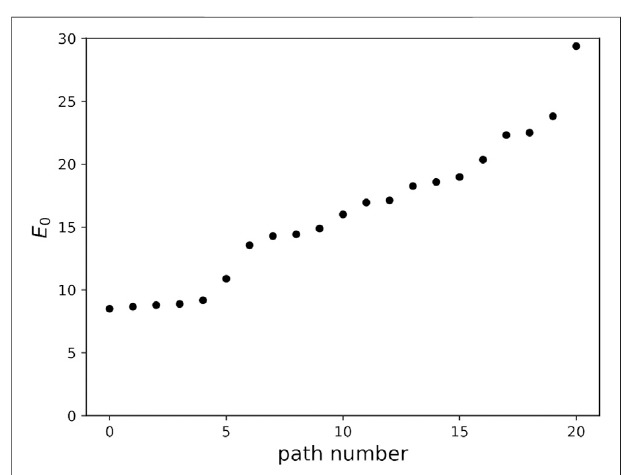
FIGURE 8 | The weight E O ranging from the most optimal (No. 0) to the least optimal (No. 20) for paths between intervals on different edgesas shown in Figure 7